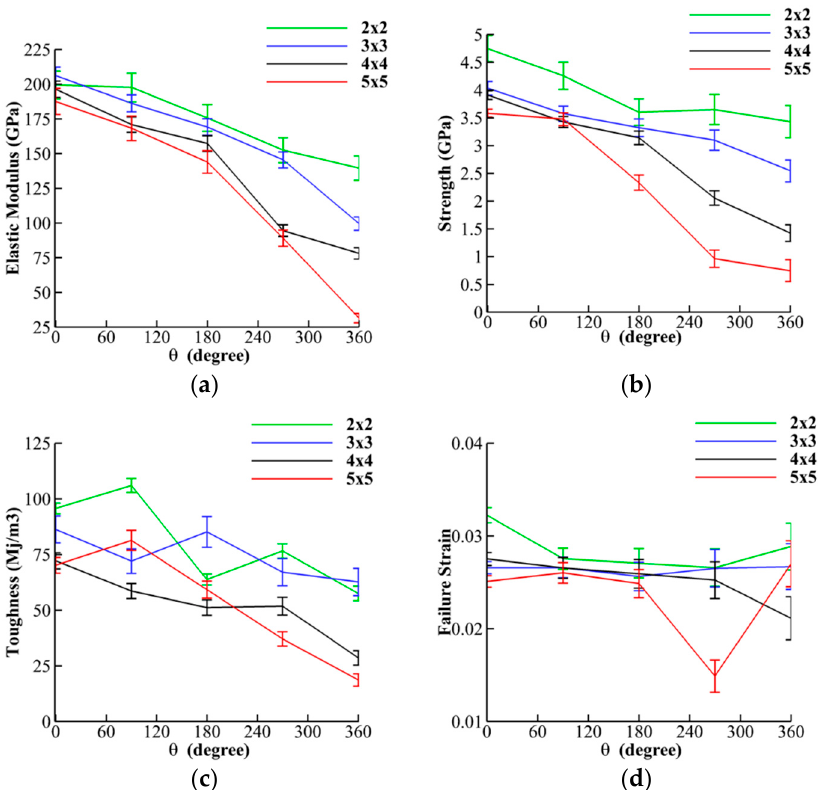
Figure 6. Mechanical performance of twisted bundle of CNCs for bundle size and 𝜖 = 1.25 kcal/mol. ( a ) elastic modulus, ( b ) strength, ( c ) toughness, and ( d ) failure strain.